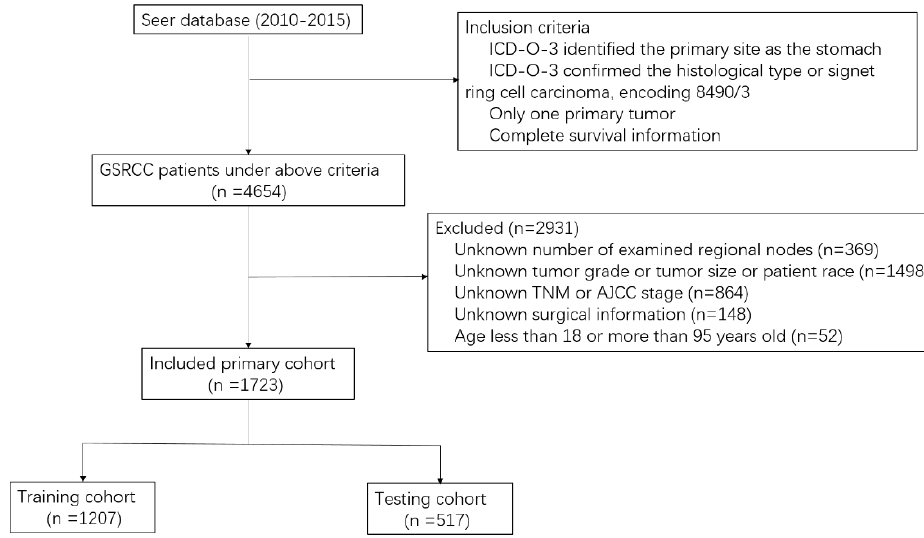
Figure 1. Flowchart of patients included in the present study.